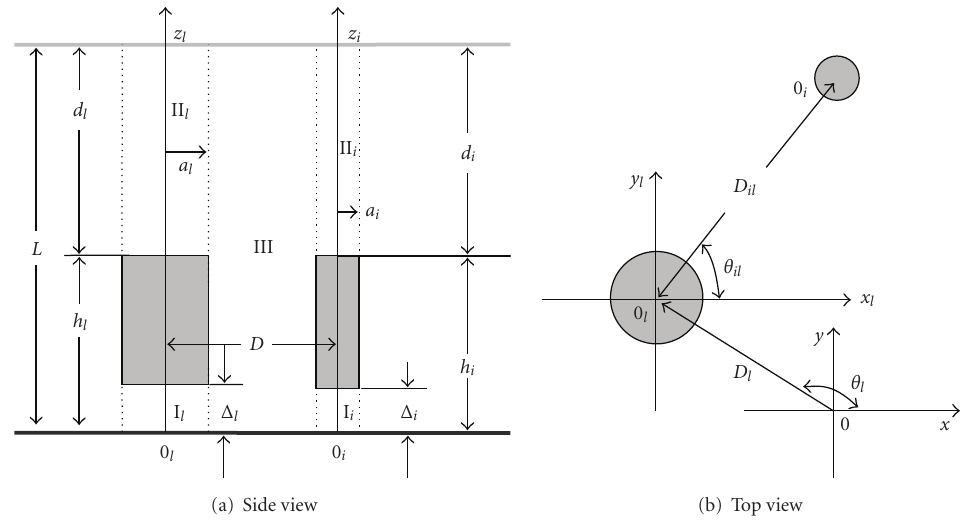
Figure 1: Analysis model of an array of multiple monopole